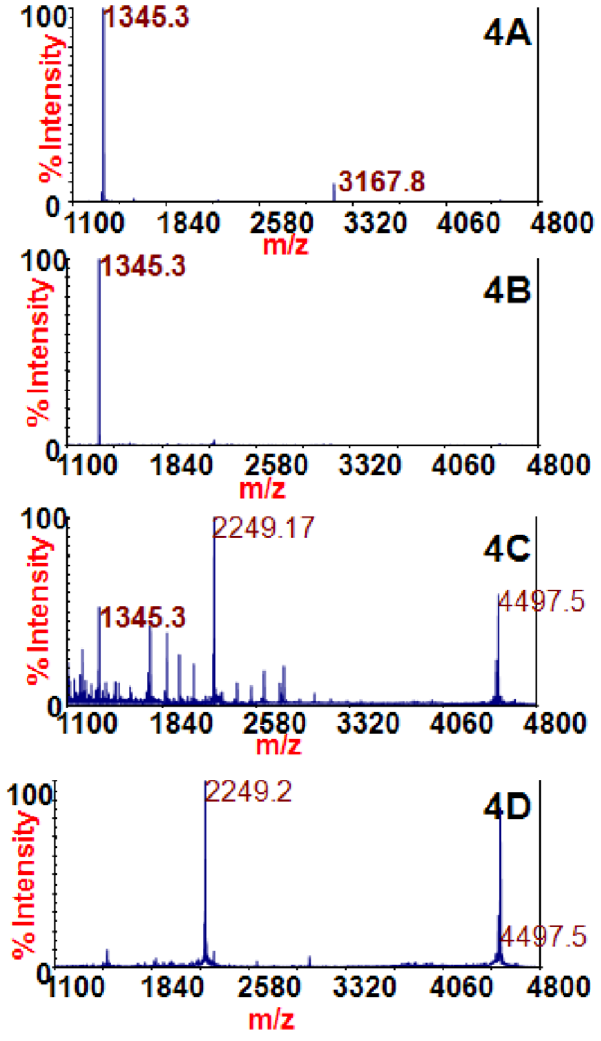
Figure 4. Mass spectra of the Endopep-MS BoNT/F reactions with /F1 (4A), /F6 (4B), /F2 (4C), or no toxin (4D) extracted using the 4E17.1 antibody-coated beads. The peptide cleavage products indicating BoNT/F are m/z 1345.2 and 3167.8 and the peptide substrate is present at m/z 4497.5.